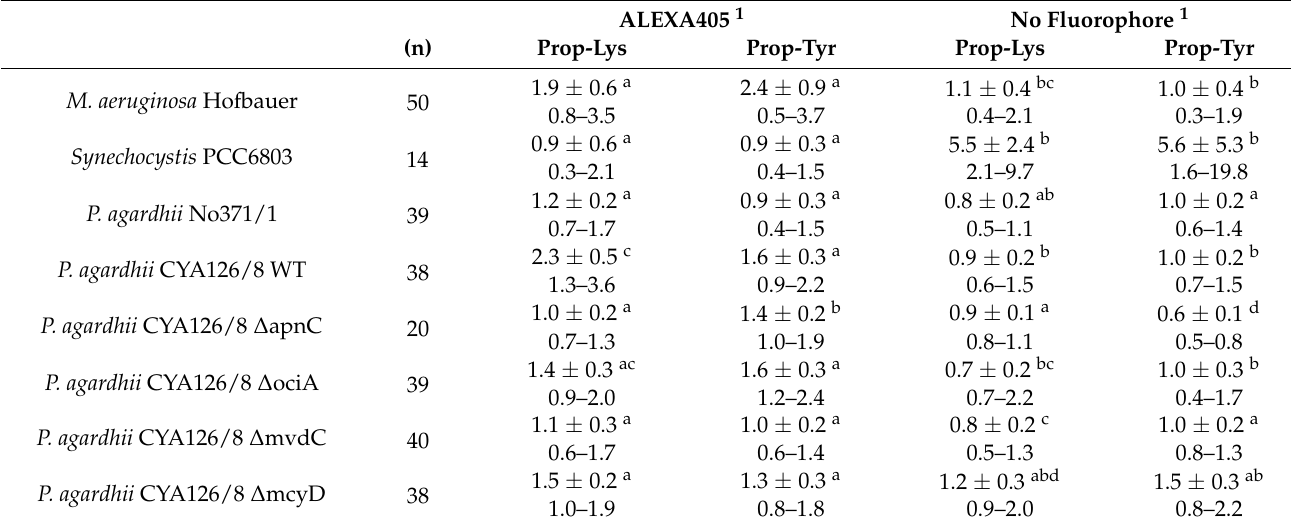
Table 3. Average ( ± SD) min–max blue fluorescence intensity obtained for individual treatments using non-natural amino acid feeding (Prop-Lys and Prop-Tyr) and subsequent labeling by ALEXA405 using copper-catalyzed azide-alkyne cycloaddition (CuAAC). The intensity was divided by the average intensity of control filaments or cells, i.e., cells were grown without amino acid addition but used for the chemical reaction under identical conditions. No Fluorophore indicates filaments or cells grown with amino acid addition but no subsequent labeling by the click-chemical reaction. n: number